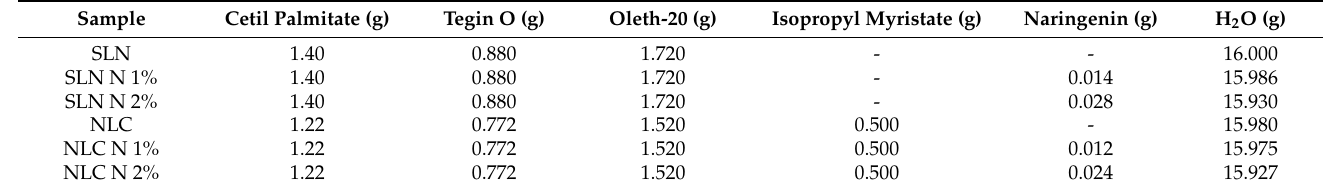
Table 1. Composition of unloaded SLN, Naringenin-loaded SLN (SLN N1% and SLN N 2%) unloaded NLC and Naringenin loaded NLC (NLC N 1% and NLC N